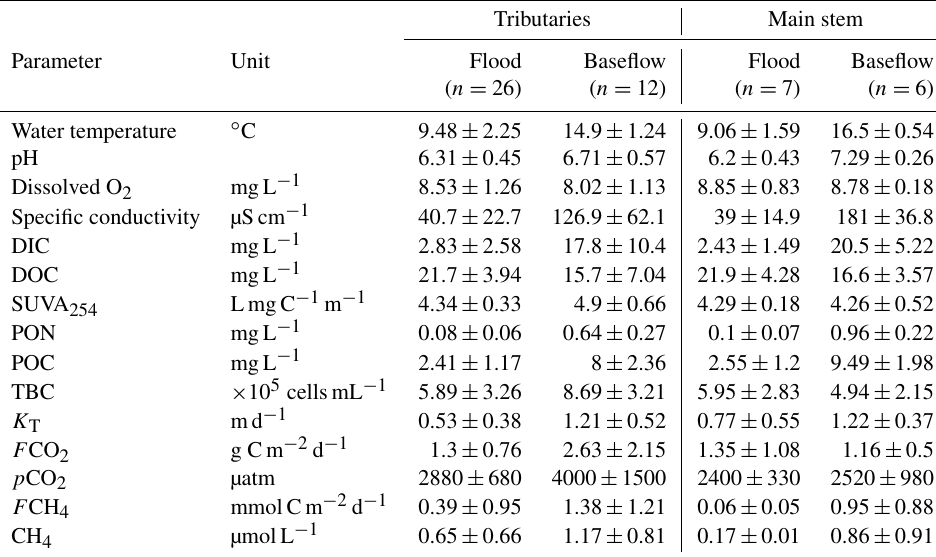
Table 1. Measured hydrochemical and GHG exchange parameters in the Ket River main stem and tributaries (average ± SD; n is the number of measurements). The F CO 2 and K T are chamber-measured CO 2 flux and gas transfer velocity, respectively, whereas diffusive CH 4 flux ( F CH 4 ) was calculated using a chamber-specific transfer